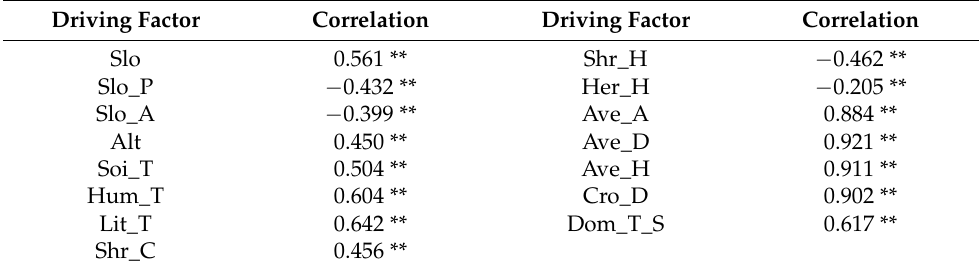
Table 5. Latent variable correlation.